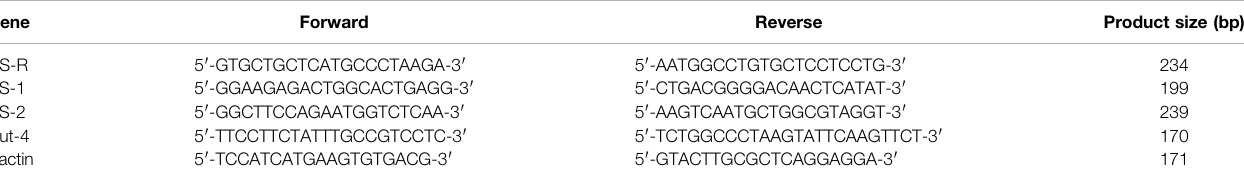
TABLE 1 | Sequences of the primers used for polymerase chain reaction. Gene Forward Reverse